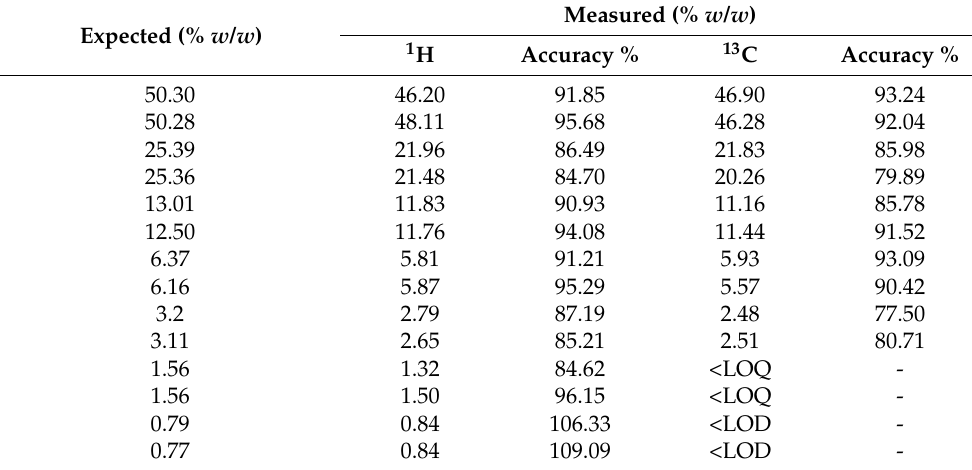
Table 2. 1 H and 13 C qNMR results of rosemary EO—corn oil binary mixtures expressed as adulterant percentage w/w